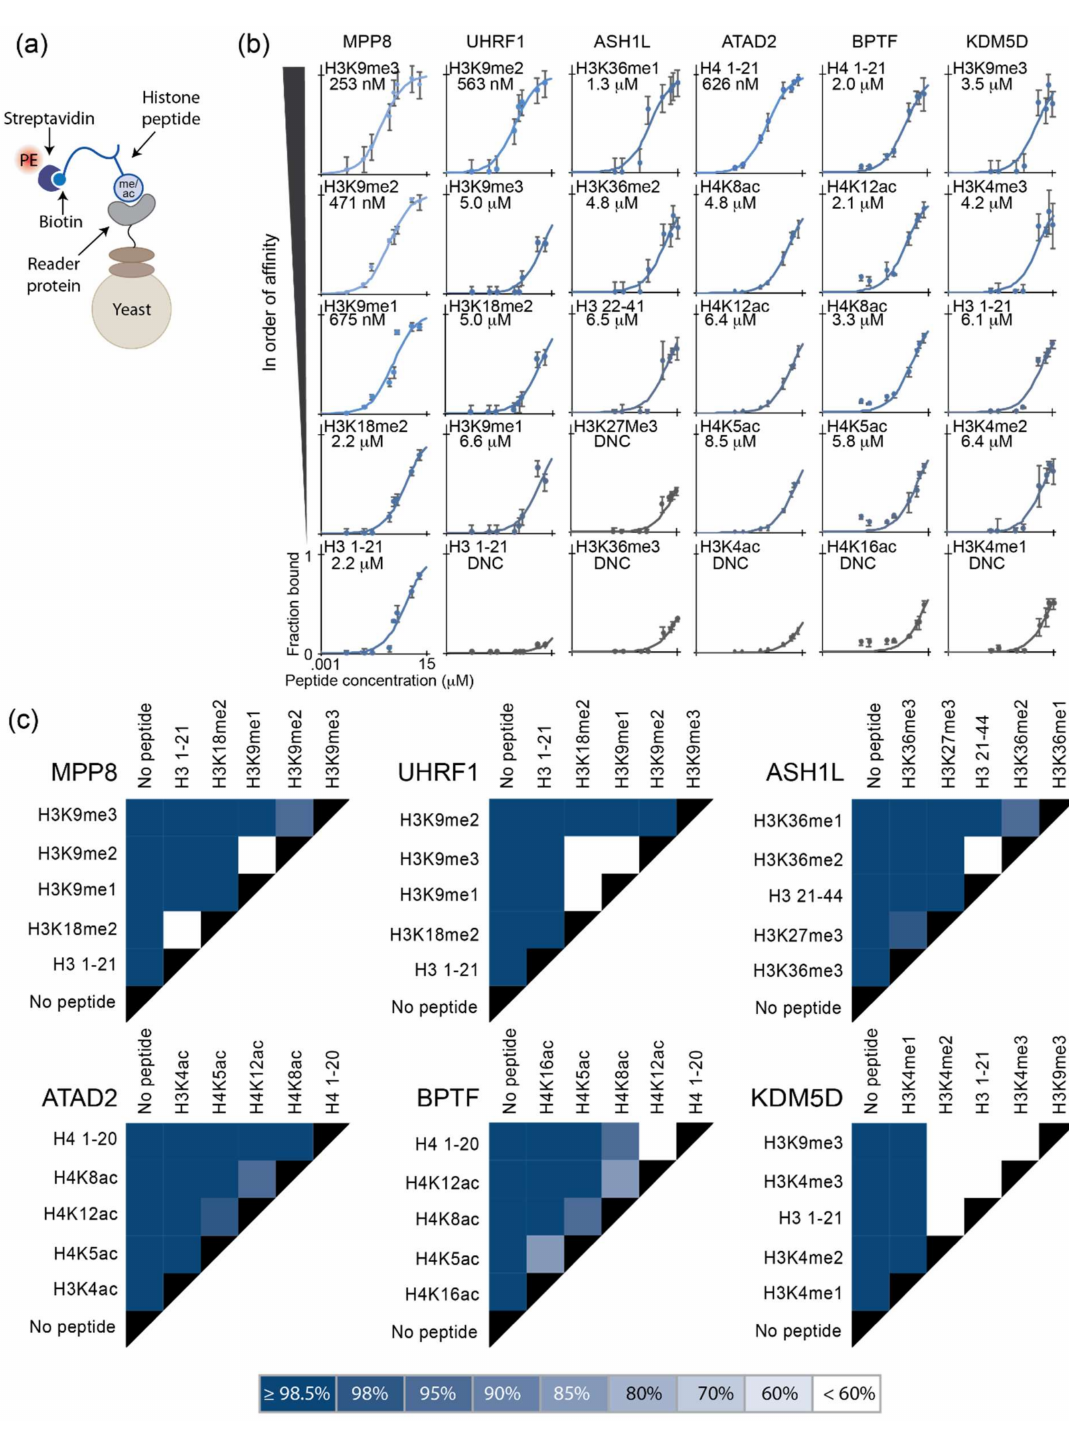
Figure 1. Yeast surface display provides a facile platform to characterize histone reader specificity. ( a ) Interaction between the biotinylated peptide and the displayed reader protein is measured via streptavidin–PE. ( b ) Binding isotherms and calculated binding affinities of the displayed reader proteins to the respective peptides; error bars represent the standard deviation from triplicate samples. ( c ) Binding affinity discrimination determined by the overlap of confidence intervals. More distinct binding affinities (K D s) exhibit higher-percentage confidence intervals that do not overlap. Darker colors are associated with a higher level of discrimination between the respective peptides. The legend indicates the confidence intervals at which binding affinities were